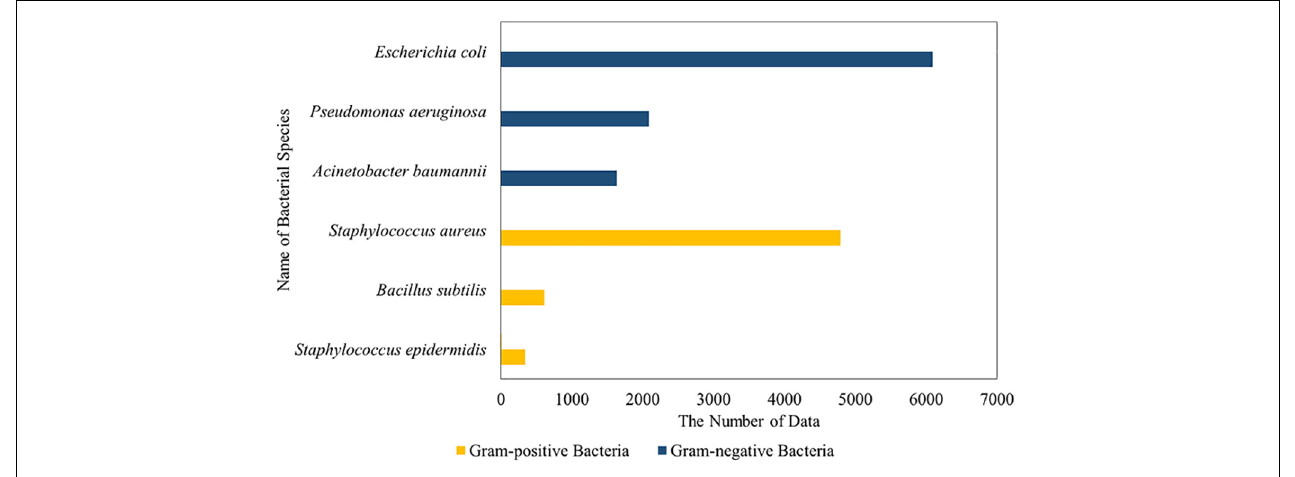
FIGURE 6 | Statistical chart of bacterial species (TOP 3).